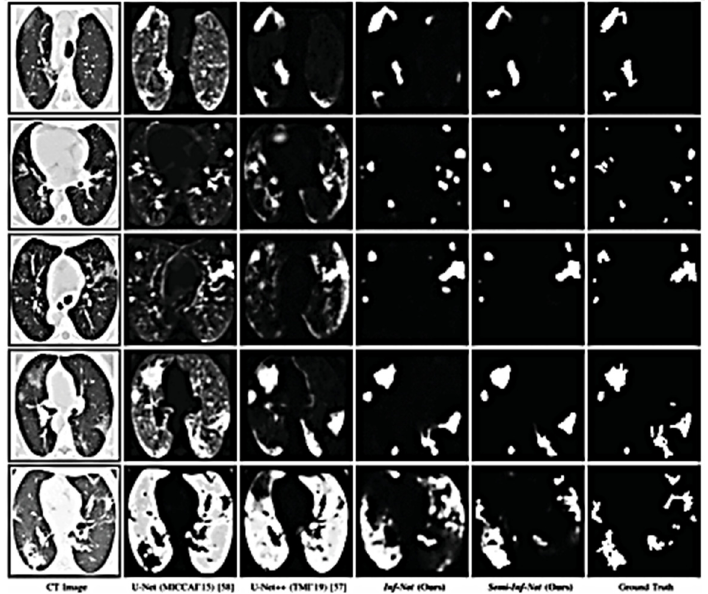
Figure 8. Inf-Net performance compared with others [73].